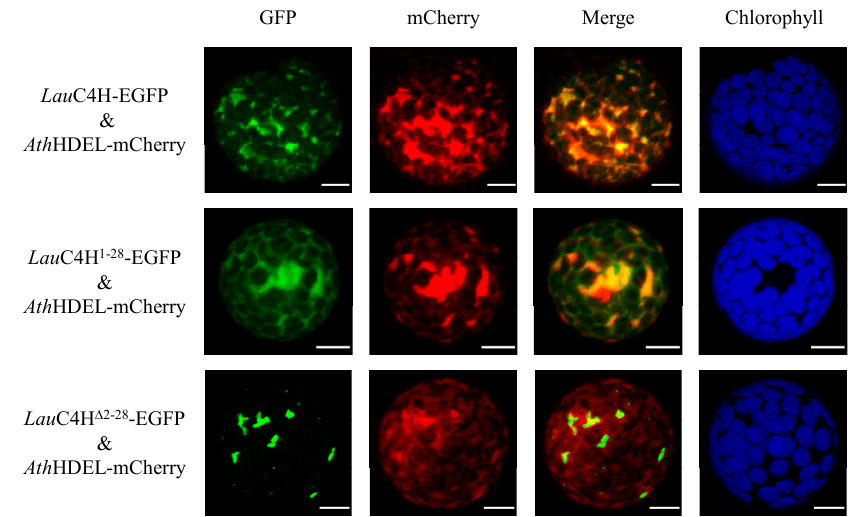
Figure 4. Subcellular localization of Lau C4H. “Green” panels show the fluorescence of Lau C4H variants fused with the enhanced green fluorescent protein (EGFP), “mCherry” panels indicate the fluorescence of endoplasmic reticulum marker (HDEL), and “Chlorophyll” panels indicate the auto-fluorescence of chloroplast. “Merged” panels represent the combined fluorescence from EGFP and mCherry. Bars = 10 μ m.